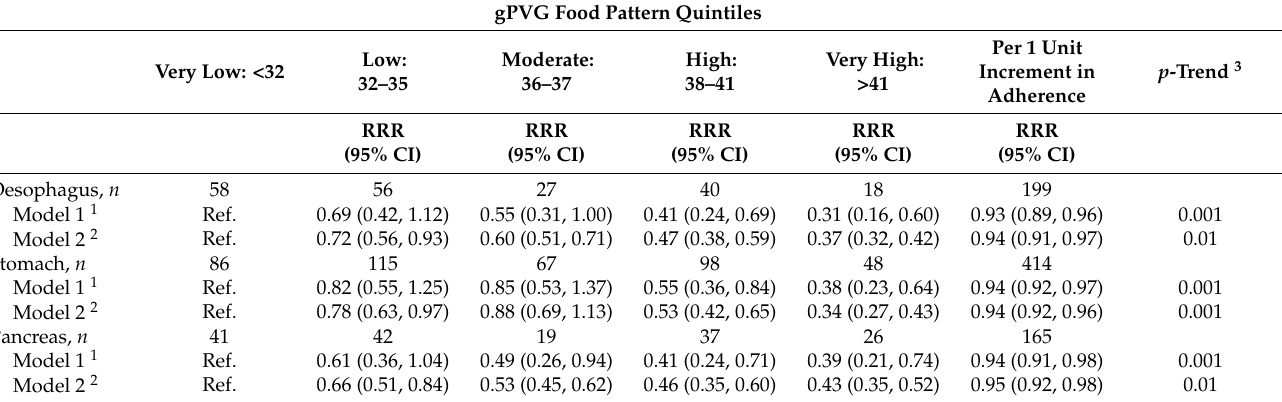
Table 3. Association between adherence to general PVG food pattern in quintiles and continuous (per 1 unit) and oesophageal, stomach, and pancreas cancer in participants of the PANESOES study ( n =